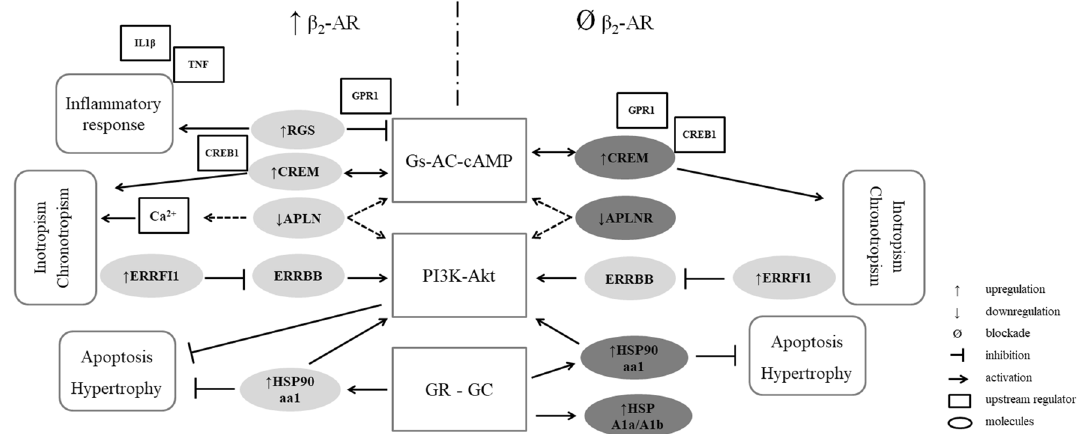
Figure 4. Schematic representation of the microarray analysis of the effect of stress on the expression of most disregulated genes in the ventricle of rats with β 2 -adrenoceptors (β 2 -AR) upregulated (unstressed and stressed untreated rats comparison; left side) and those with the β 2 -AR antagonized by ICI118,551 (comparison of unstressed and stressed ICI-treated rats; right side). The signaling pathways related to these genes are listed in the center of the figure, and the putative effect on cardiac function and structure are listed in the respective side of each